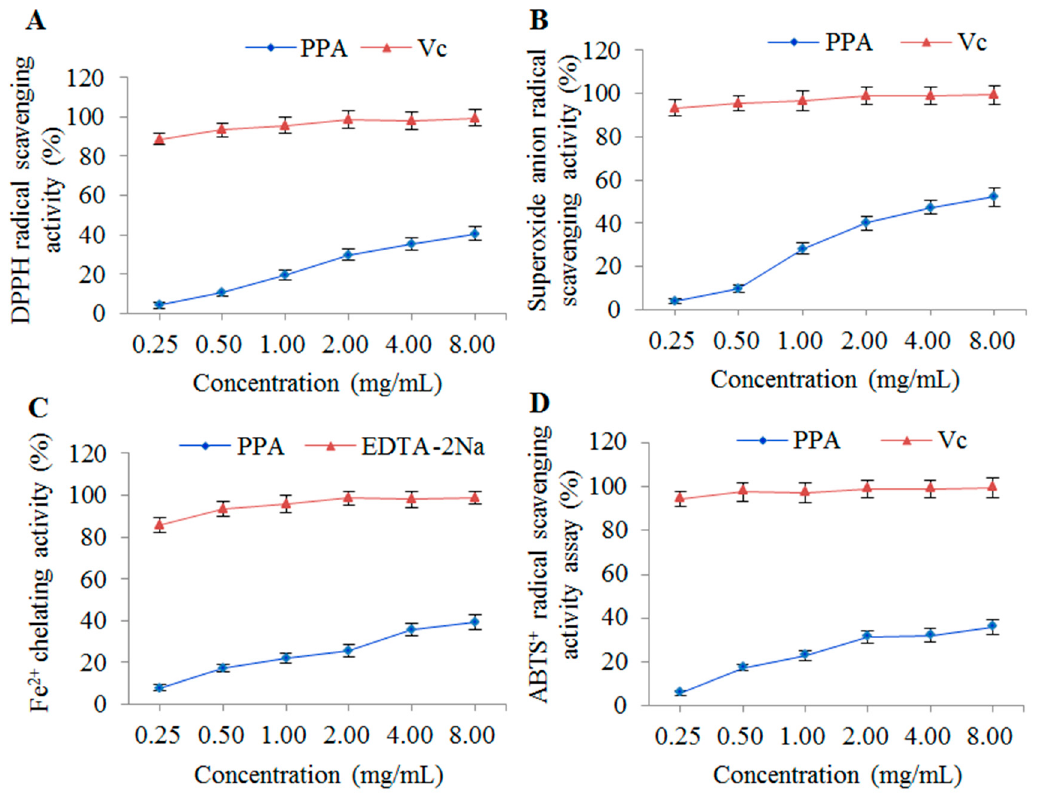
Figure 8. Antioxidant activities of PSA. ( A ) DPPH radical scavenging assay; ( B ) superoxide anion radical scavenging assay; ( C ) Fe 2+ chelating assay; ( D ) ABTS + radical scavenging assay.